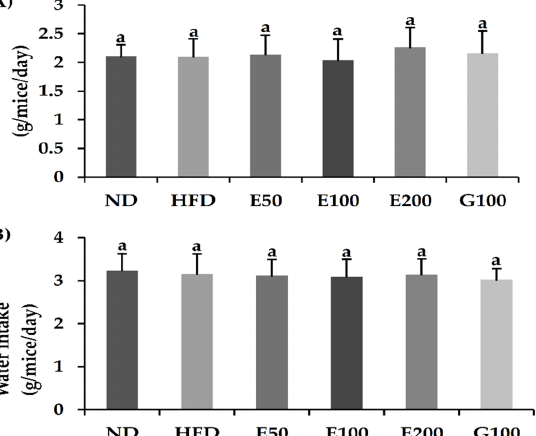
treated with Garcinia cambogia water extract at concentrations of 100 mg/kg/day.